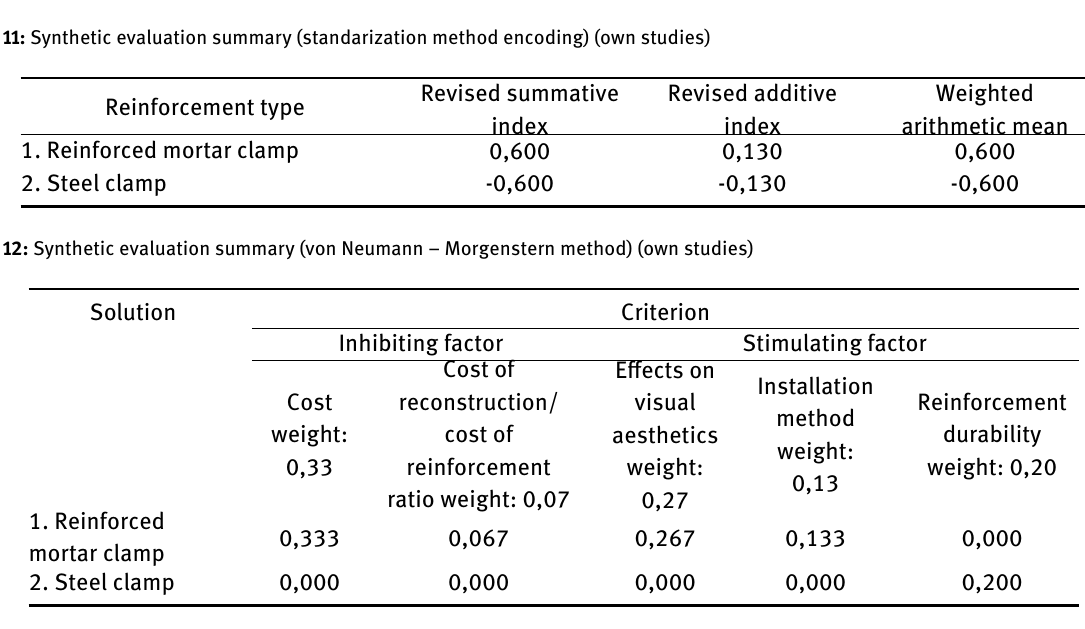
Table 13: Synthetic evaluation summary (von Neumann – Morgenstern method) (own studies) Reinforcement